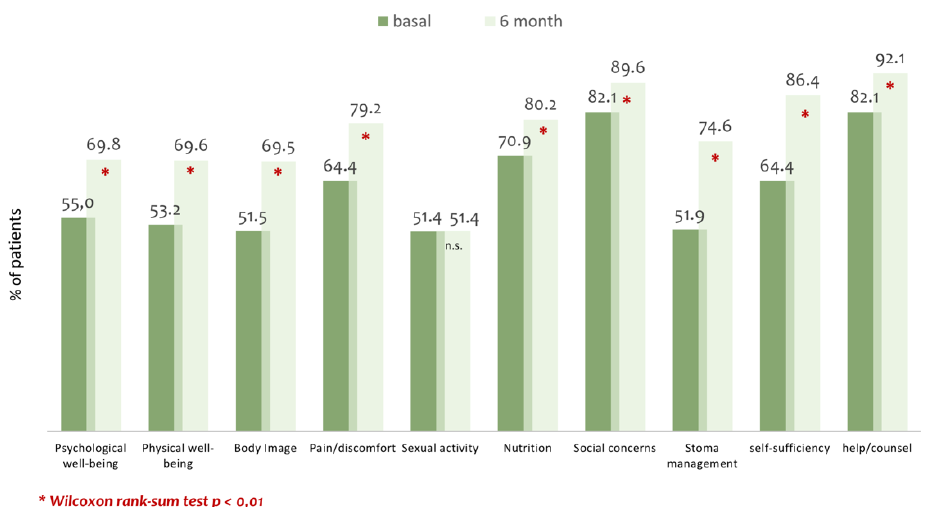
Figure 2. Mean score obtained with the Stoma Quality of Life Index specific survey. Range 0 = worse quality of life; 100 = better quality of life.